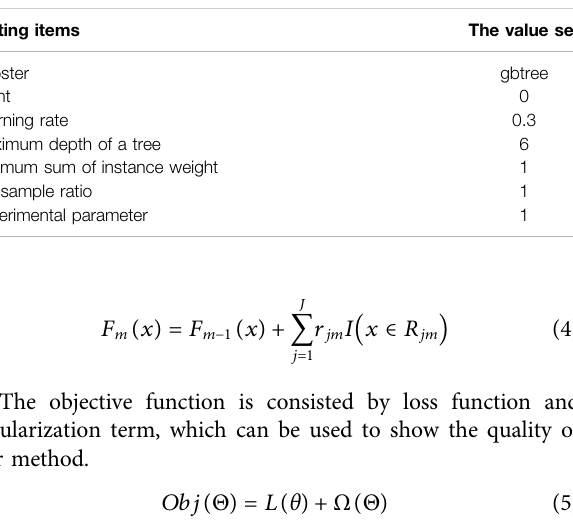
TABLE 3 | The results of the ten